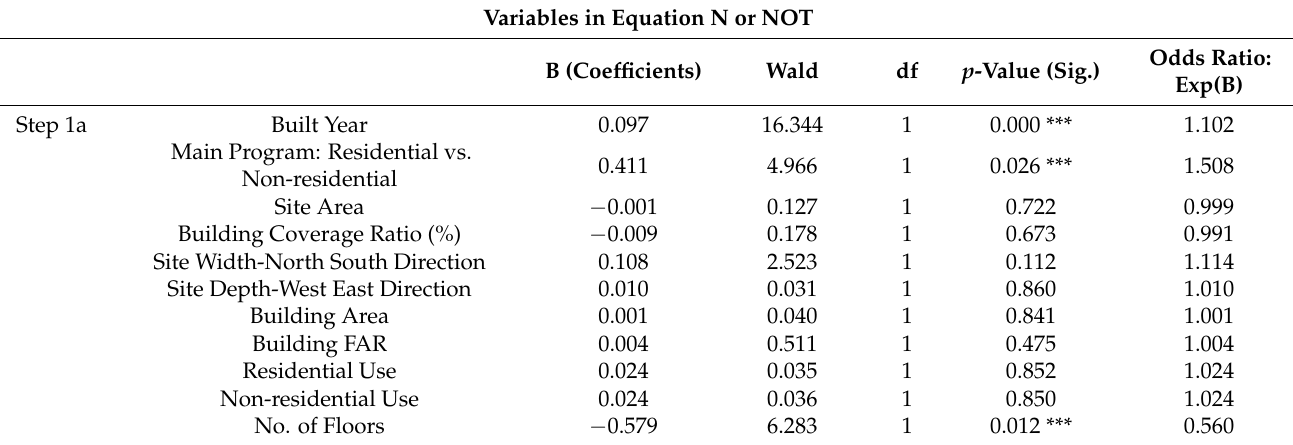
Table 7. Binary logistic regression analysis result: N or